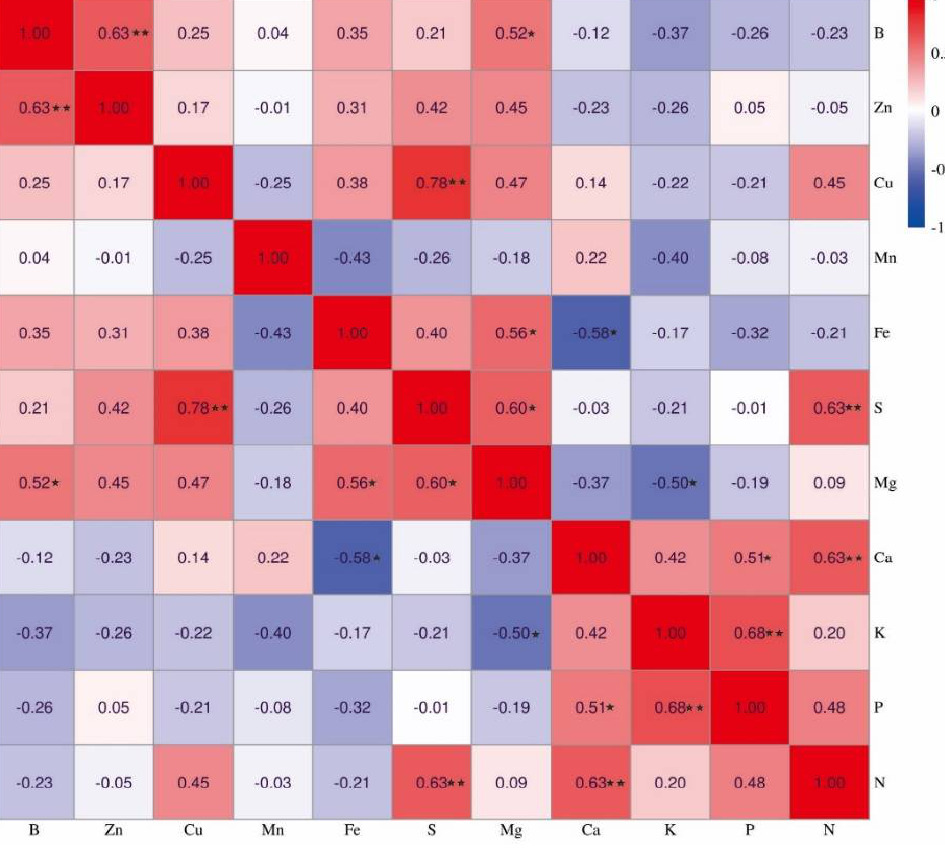
Figure 5. The correlation coefficients of the nutrient elements of the Tainong mango leaves. *. Sig- nificantly different at the 0.05 level, **. Significantly different at the 0.001 level. Table 5. The Tainong mango diagnostic critical